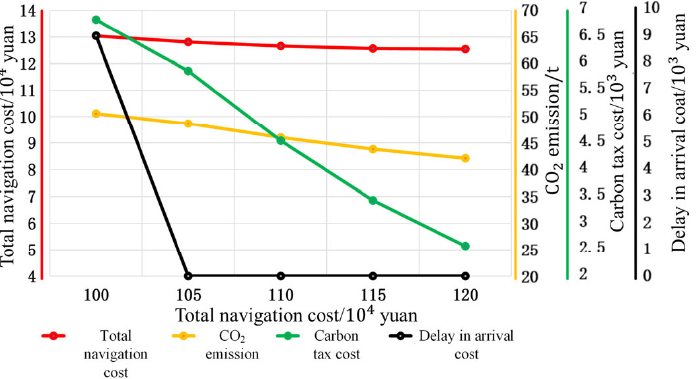
Figure 14. Total shipping costs, CO 2 emissions, carbon tax costs, and delayed arrival penalties with different latest arrival time constraints.